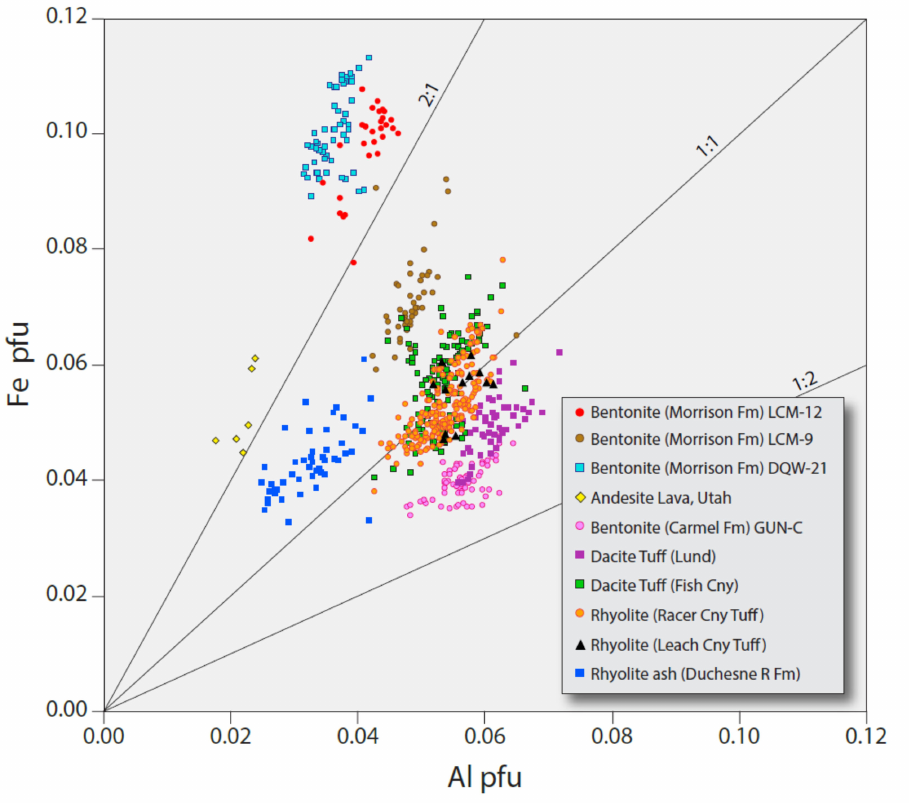
Figure 4. Examples of the clustering of titanite compositions from individual volcanic units on an Fe versus Al plot. Unit ages range from Jurassic to Cenozoic and come from Utah, Colorado, and